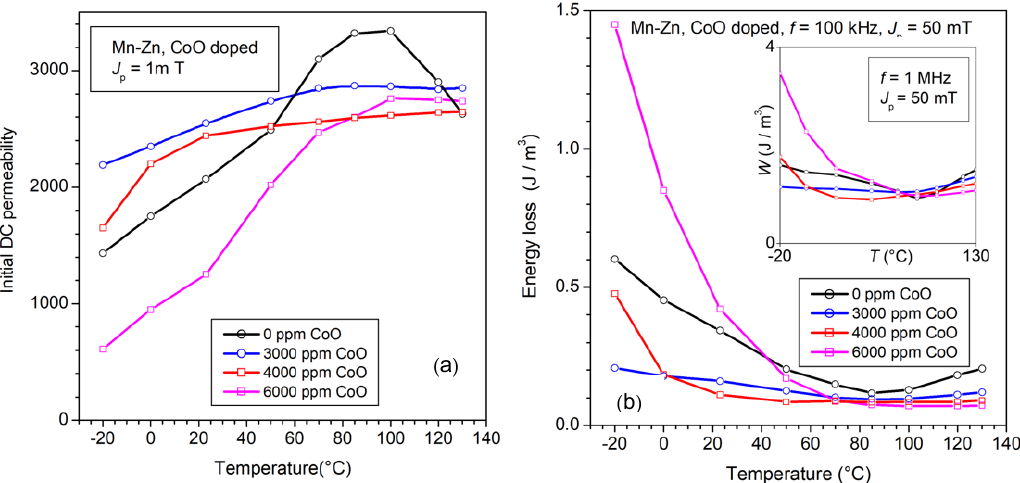
Figure 10. The dependence on the temperature T of the magnetic properties of Mn-Zn ferrites is mitigated by optimal CoO doping. We observe a smoothed behavior versus T of the DC initial permeability ( a ) and of the energy loss measured at 100 kHz and 1 MHz for J p = 50 mT ( b ) for CoO addition of 3000–4000 ppm. (Adapted from Ref. [42]).